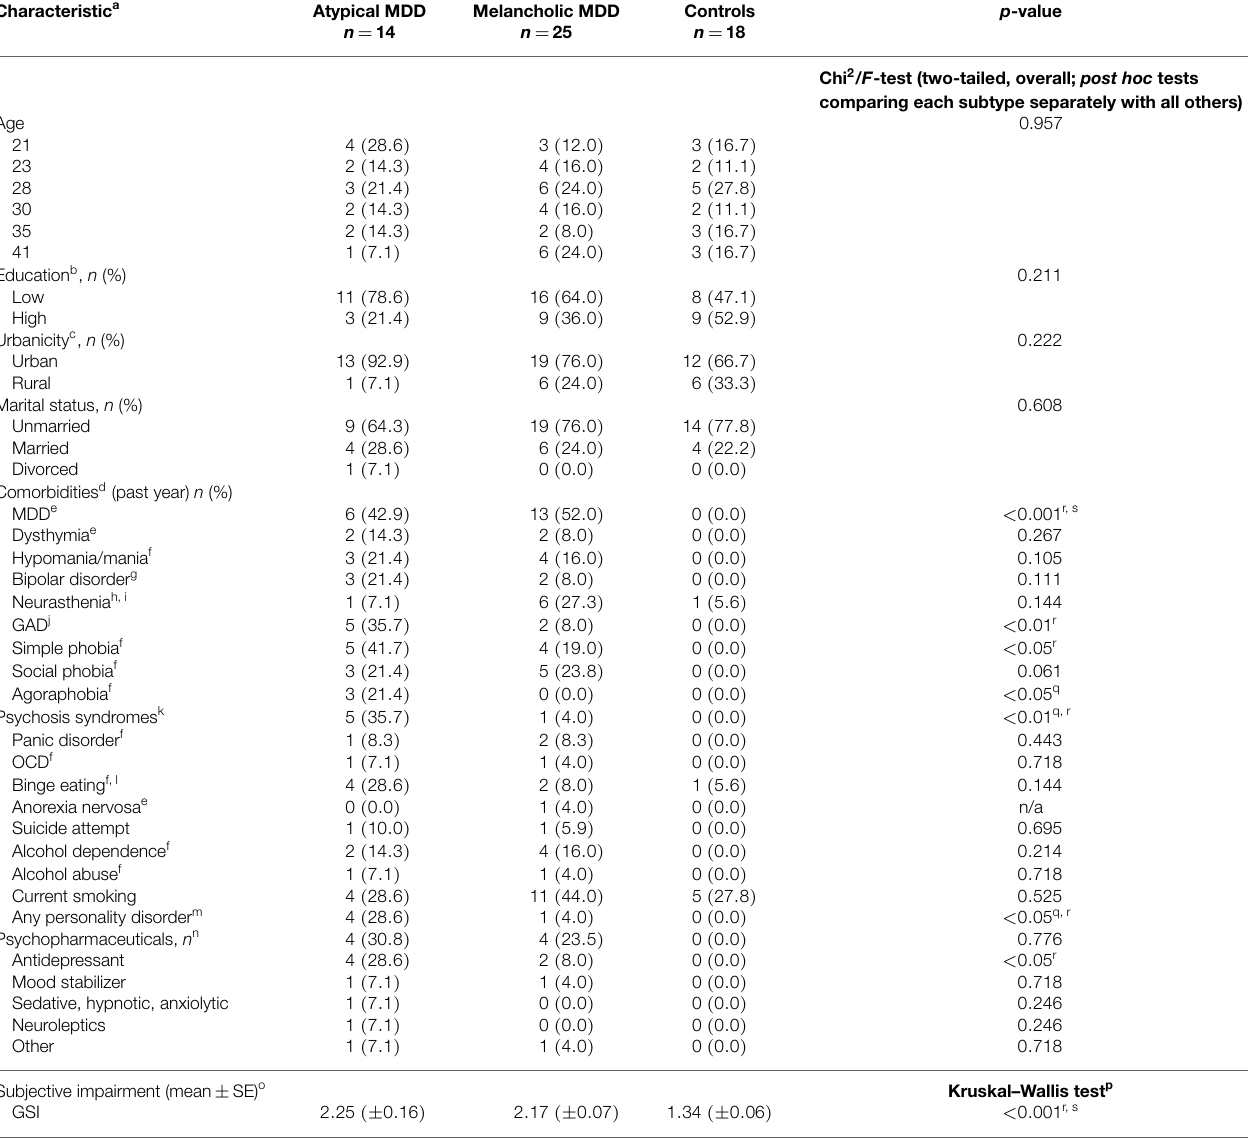
TABLE 1 | Psychosocial characteristics for men belonging to the depressive subtypes derived from latent class analyses ( n = 39) and healthy controls ( n = 18), unadjusted . Characteristic